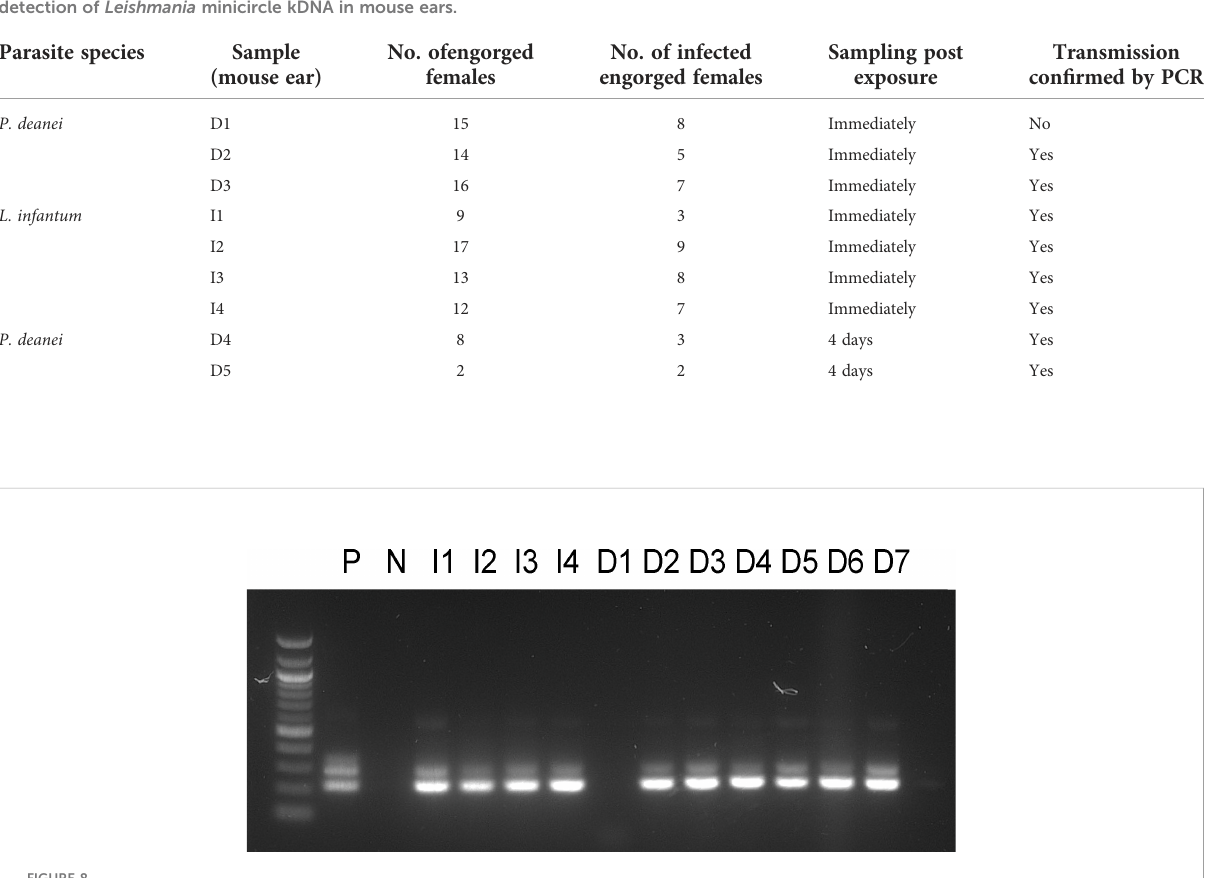
FIGURE 8 Ampli fi cation of a 226 bp Leishmania 18S sequence. P, positive control from cultured parasites; N, negative control; I1-4, mice ears exposed to L. longipalpis infected with L. infantum , mice killed immediately post experiment; D1-3, mice ears exposed to L. longipalpis infected with P. deanei , mice killed immediately post experiment; D4-5, mice ears exposed to L. longipalpis infected with P. deanei and D6-7, their draining lymph nodes, mice killed 4 days post experiment.